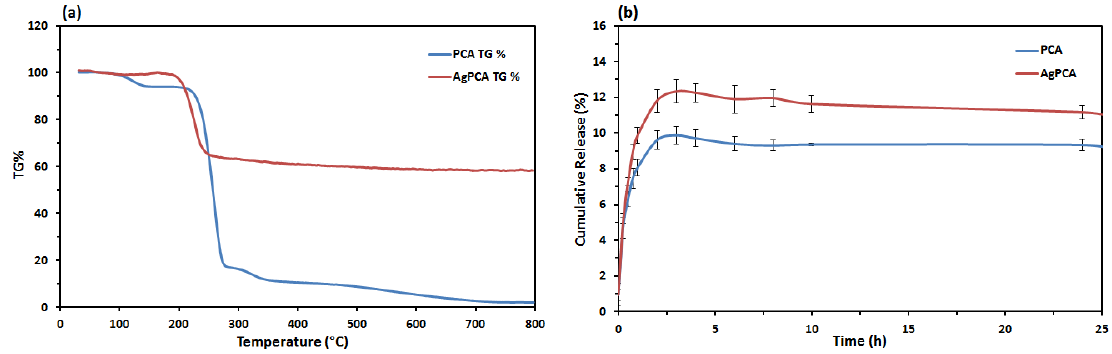
Figure 6. Thermogravimetric analysis and drug profile release of PCA and Ag-PCA. ( a ) TGA thermograms of PCA and AgPCA; ( b ) Drug release profile of PCA and AgPCA.